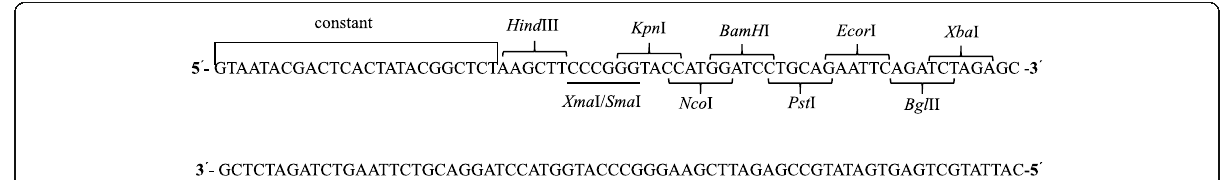
Fig. 1 Structure of adaptor consists of two complementary oligos that comprise ten restriction